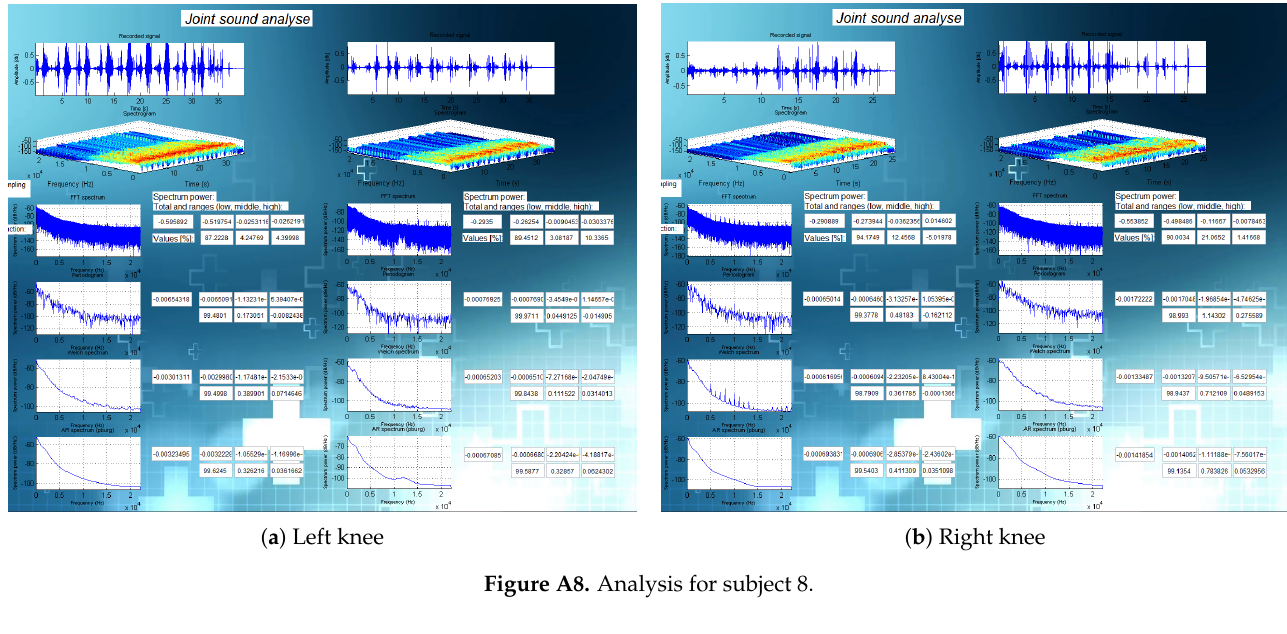
Figure A8. Analysis for subject 8.